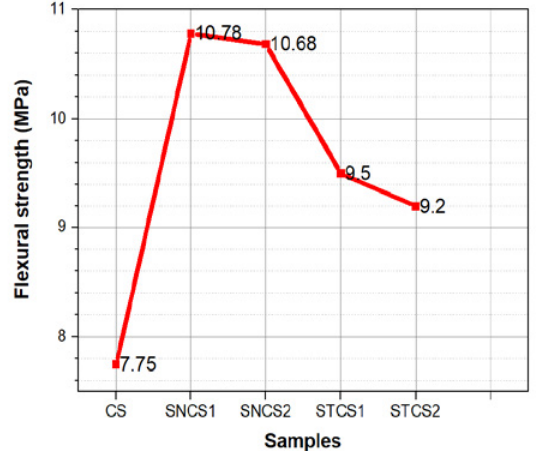
Fig. 6. Variations in flexural strength of the cement-based Figure 6. Variations in flexural strength of the cement-based composite.